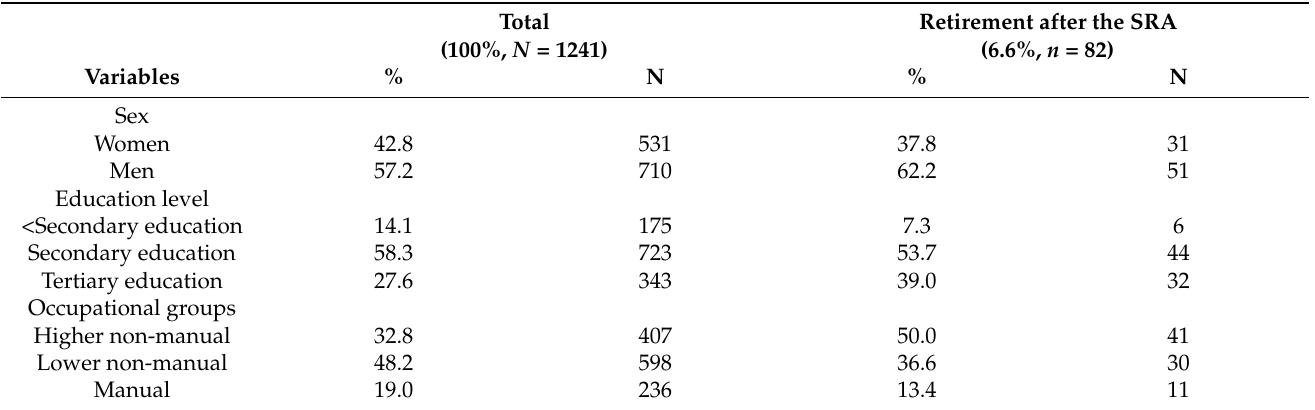
Table 1. Participant